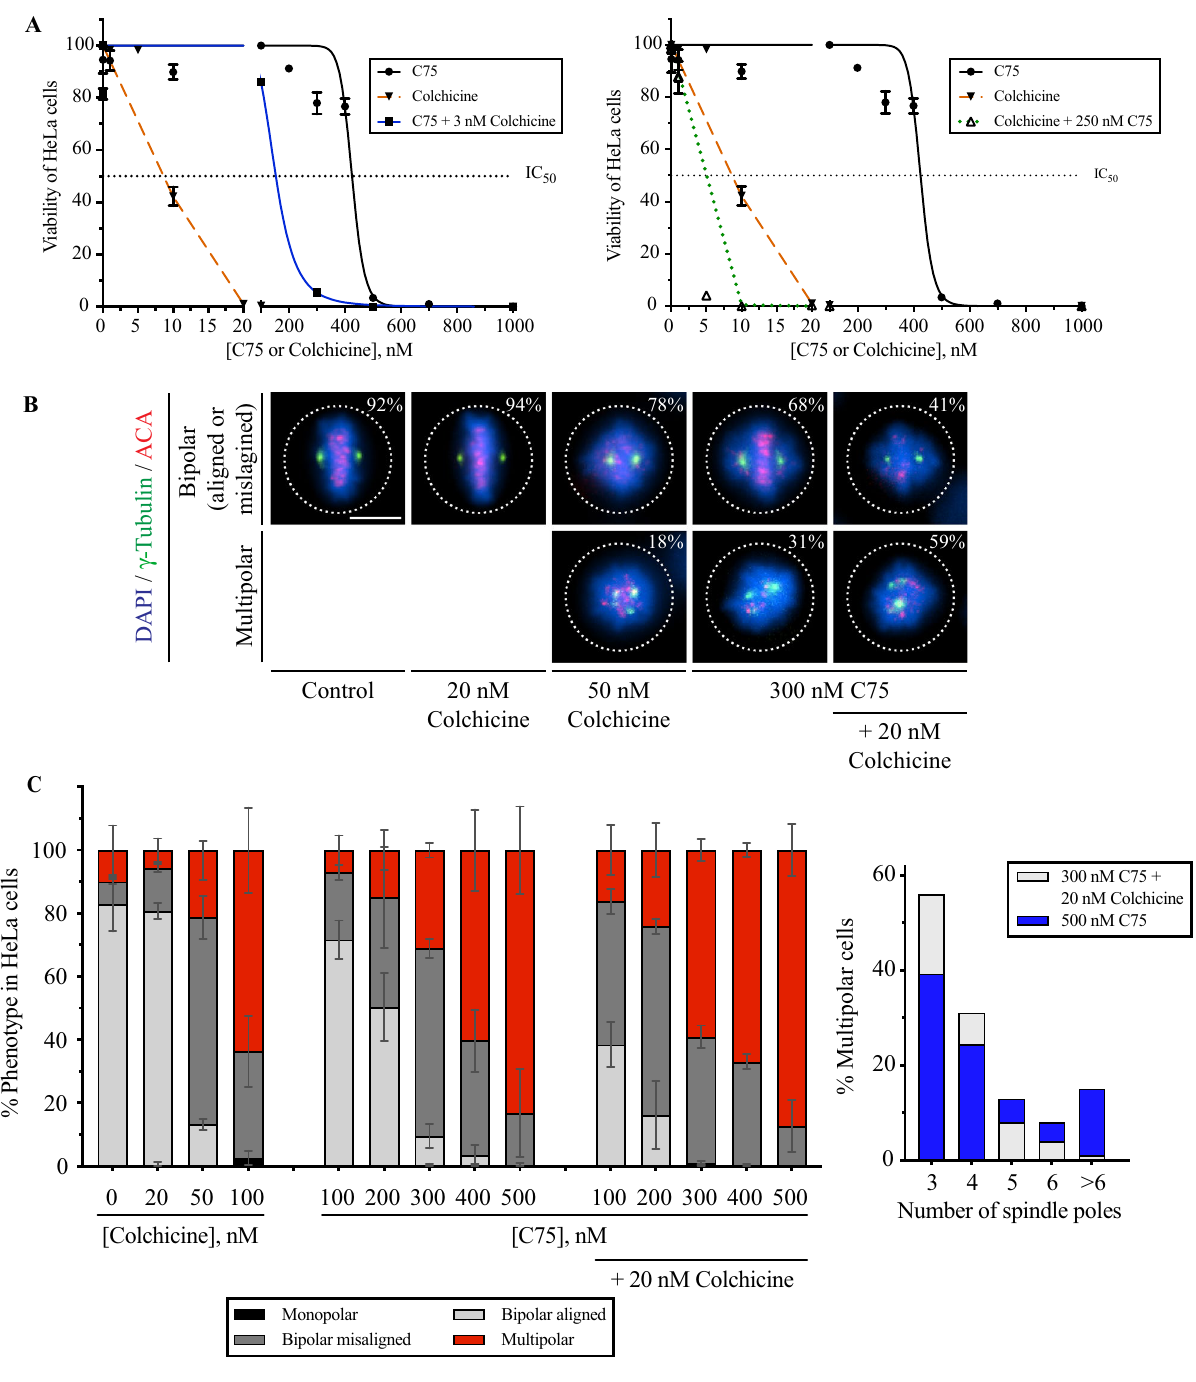
Figure 3. Combining C75 with colchicine enhances lethality and increases spindle phenotypes. ( A ) Line graphs show the IC 50 for the viability (dotted black lines) of HeLa cells treated with varying concentrations of C75, colchicine, or both after three population doubling times as indicated. The graph on the left shows changes in viability (Y-axis) with increasing concentrations of C75 (X-axis; black line), colchicine (dotted orange line), and C75 with 3 nM colchicine (blue line). The graph on the right shows the changes in viability with colchicine and 250 nM C75 (green dotted line). The bars indicate SEM for N = 3 experimental replicates. ( B) Images show fixed HeLa cells stained for DNA (DAPI; blue), g-tubulin (green) and ACA (centromeres; red) after treatment for 5 h with colchicine, C75 or both. The proportion of cells with bipolar spindles (aligned or misaligned chromosomes) and multipolar spindles are indicated on the images. The scale bar is 10 µm. ( C) Bar graphs show the proportion of HeLa cells from B) with bipolar aligned (light grey), bipolar misaligned (dark grey), multipolar (red) or monopolar (black) spindles. Bars show standard deviation. Statistical analysis was done using two-way ANOVA test and a post-hoc Tukey’s multiple comparison test with a 90% CI, and multiplicity adjusted p = < 0.0831; a single asterisk indicates significance to the control (DMSO) and two indicates significance to C75. ( D) A bar graph shows the percentage of multipolar HeLa cells from ( C ) with different numbers of spindle poles after treatment with 300 nM C75 plus 20 nM colchicine (light grey) or 500 nM C75